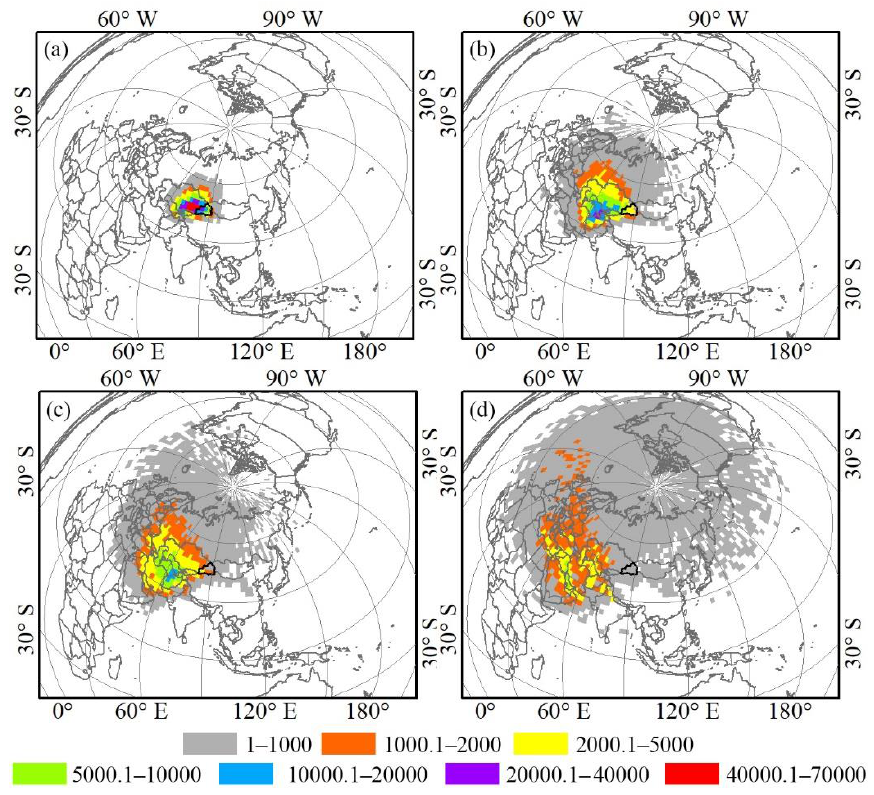
Figure 6. The quantitative water vapor transport affected Northern Xinjiang precipitation by air trajectories (specific humidity (g/kg)/2.5° × 2.5°) before arriving in Northern Xinjiang: ( a ) −24 h, ( b ) −72 h, ( c ) −120 h and ( d ) −264 h. Table 3. Total air trajectories and total water vapor contributions of snow season in six water vapor source regions from 1980 to